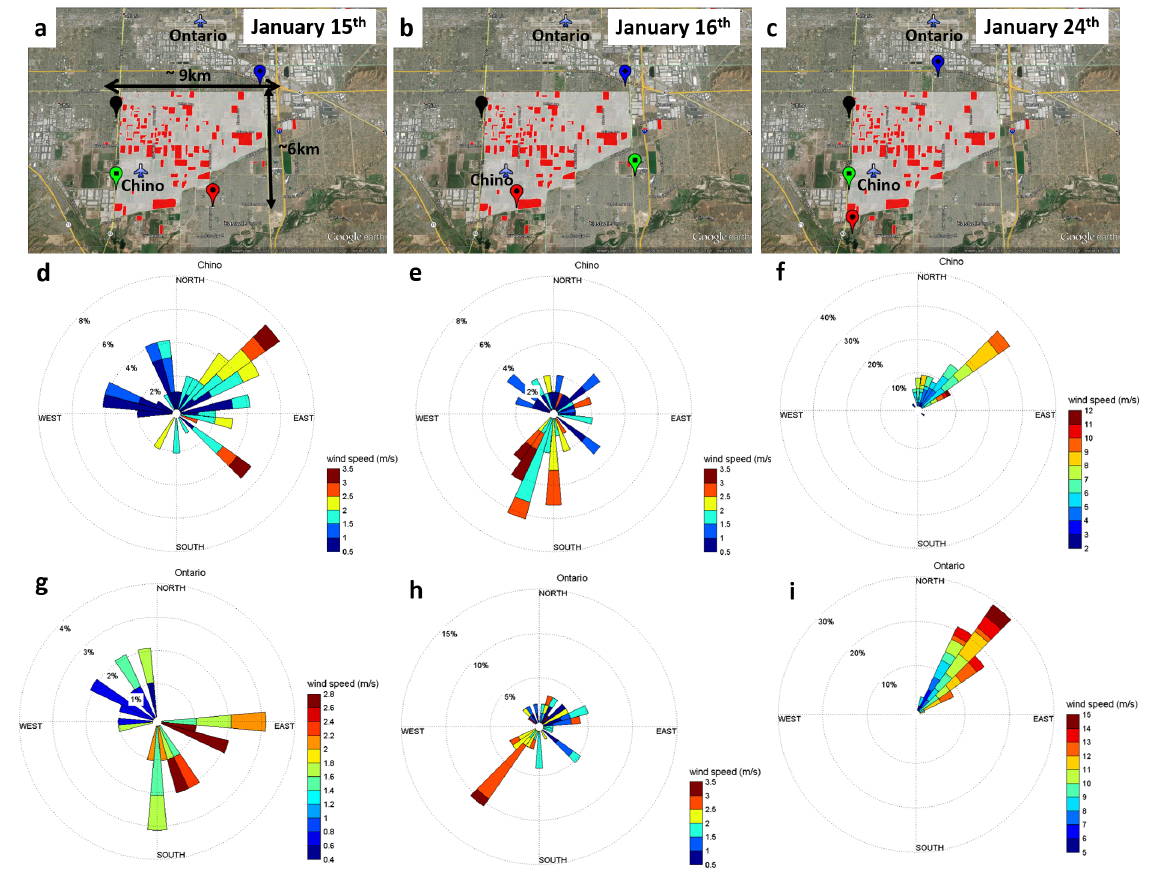
Figure 1. Three different days of measurements during the field campaign at Chino ( ∼ 9 × 6km) on 15, 16, and 24 January 2015. Panels (a–c) show the chosen locations of the four EM27/SUN (black, red, green, and blue pins correspond to the Caltech, LANL, Harvard1, and Harvard2 instruments, respectively). The red marks on the map correspond to the dairy farms. Lower panels show wind roses of 10min averages of wind directions and wind speeds measured at the two local airports (at Chino on d–f , and at Ontario on g–i ). Map provided by Google Earth V 7.1.2.2041, US Dept. of State Geographer, Google, 2013, Image Landsat, Data SIO, NOAA, US, Navy, NGA, and